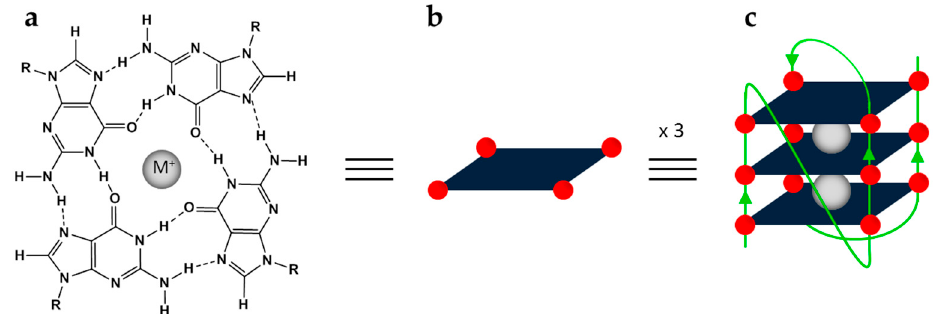
Figure 1. The G-quadruplex structure. ( a ) Chemical structure and ( b ) schematic illustration of a G-tetrad, composed of four guanines linked together through Hoogsteen H-bonds; M + represents the monovalent cation coordinated at the centre of the tetrad. ( c ) Example of intramolecular G4 structure.